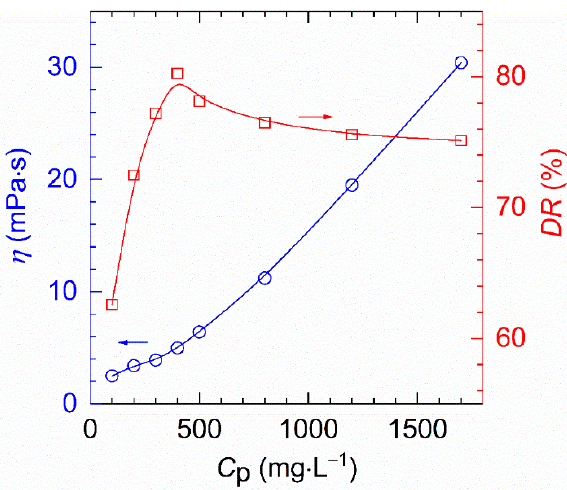
Figure 9. The dependence of drag reduction and apparent viscosity on polymer concentration (T, 30 ° C; shear rate, 170 s − 1 ; flux, 170 L ⋅ min − 1 ).